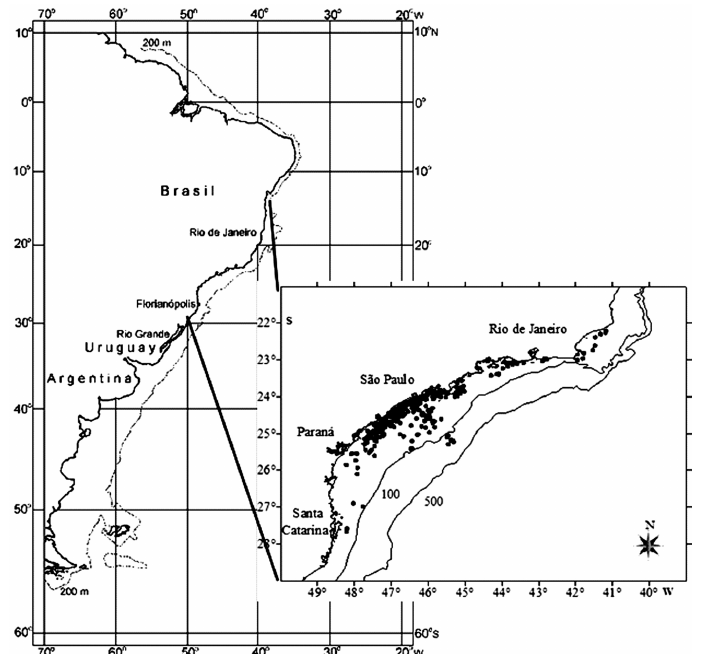
F IG . 1. – Map of the southeastern coast of Brazil showing the study area. Symbols represent the fishing hauls where specimens of Rioraja agassizi were